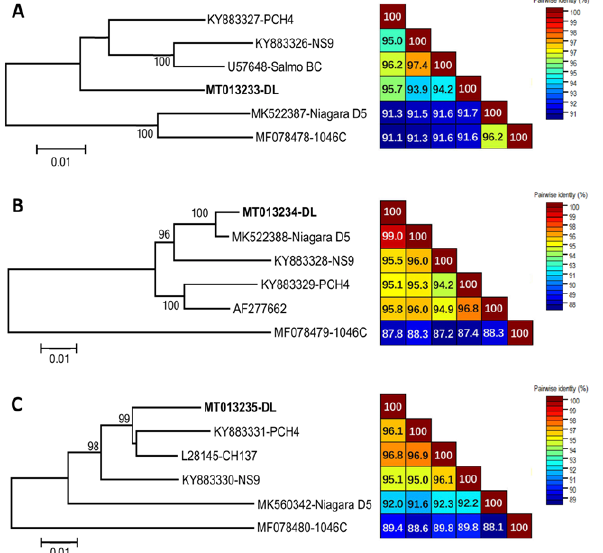
Figure 1. Phylogenetic analyses and matrix of pairwise identities based on prune dwarf virus (PDV) full-length genomic sequences of RNA1 (A), RNA2 (B) and RNA3 (C). The PDV-DL isolate exam- ined in this study is marked in bold. Phylogenetic trees were con- structed by the neighbor-joining (NJ) method with 1,000 bootstrap replicates, and genetic distance was calculated by the Tamura three- parameter model using MEGA 6.0. The pairwise identities were cal- culated by the ClustalW algorithm using SDT 1.0 software.